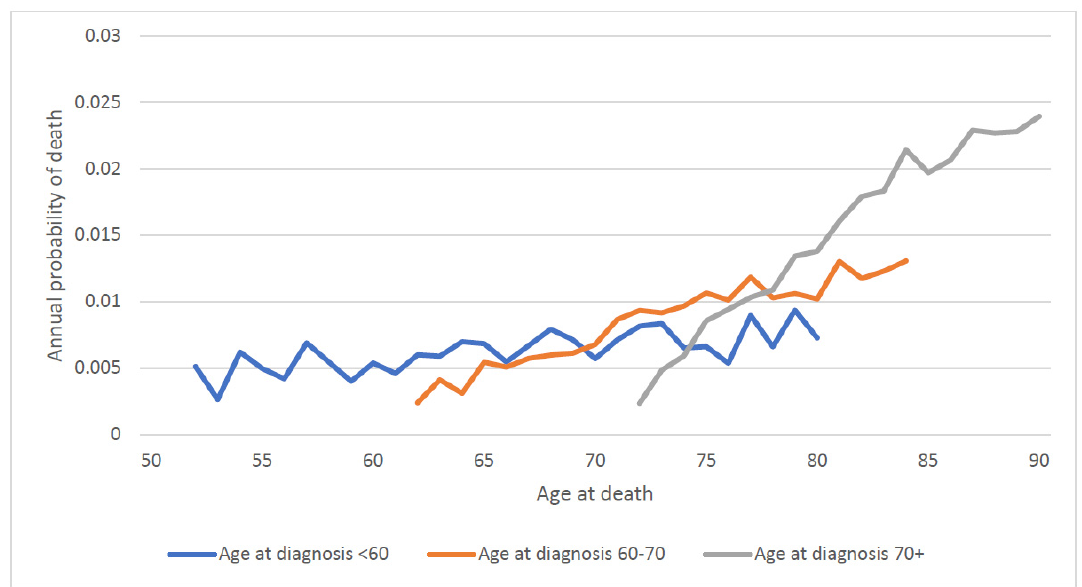
Figure 5. Annual prostate specific mortality by attained age (entire cohort).